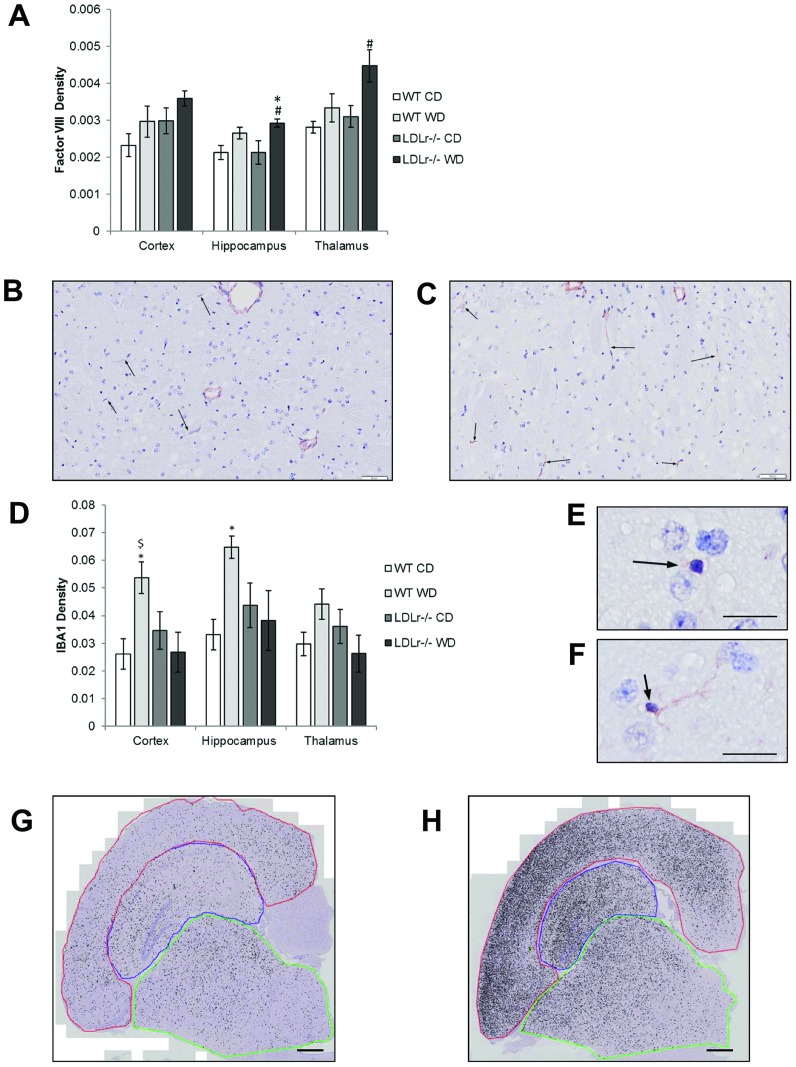
Factor VIII immunostaining density increases in hippocampus and thalamus of LDLr -/- while IBA1 increases in the cortex and hippocampus of C57BL/6 (WT) fed a western diet.Area density of factor VIII and IBA1 immunostaining in coronal section of C57BL/6 (WT) or LDLr -/- mice fed control (CD) or western diet (WD) as determined by image analysis (A and D). Representative images comparing factor VIII immunostaining in thalamus of LDLr -/- mice fed CD (B) or WD (C) (scale bar = 50μm). WD fed animals had more granules of factor VIII positive material in capillaries (arrows). Microglia in control fed mice (E) have most IBA-1 positivity surrounding the nucleus while those from western diet (F) fed animals have denser staining that extends through elongate strands of cytoplasm (scale bar = 20μm). Representative images comparing IBA1 immunostaining in cortex (red), hippocampus (blue) and thalamus (green) of WT mice fed CD (G) or WD (H) (scale bar = ~0.5mm). Statistical differences from WT (*) or LDLr -/- (#) CD fed mice or LDLr-/-WD fed ($), as determined by ANOVA with Tukey’s multiple comparisons post hoc test p<0.05, n = at least 5/grp).